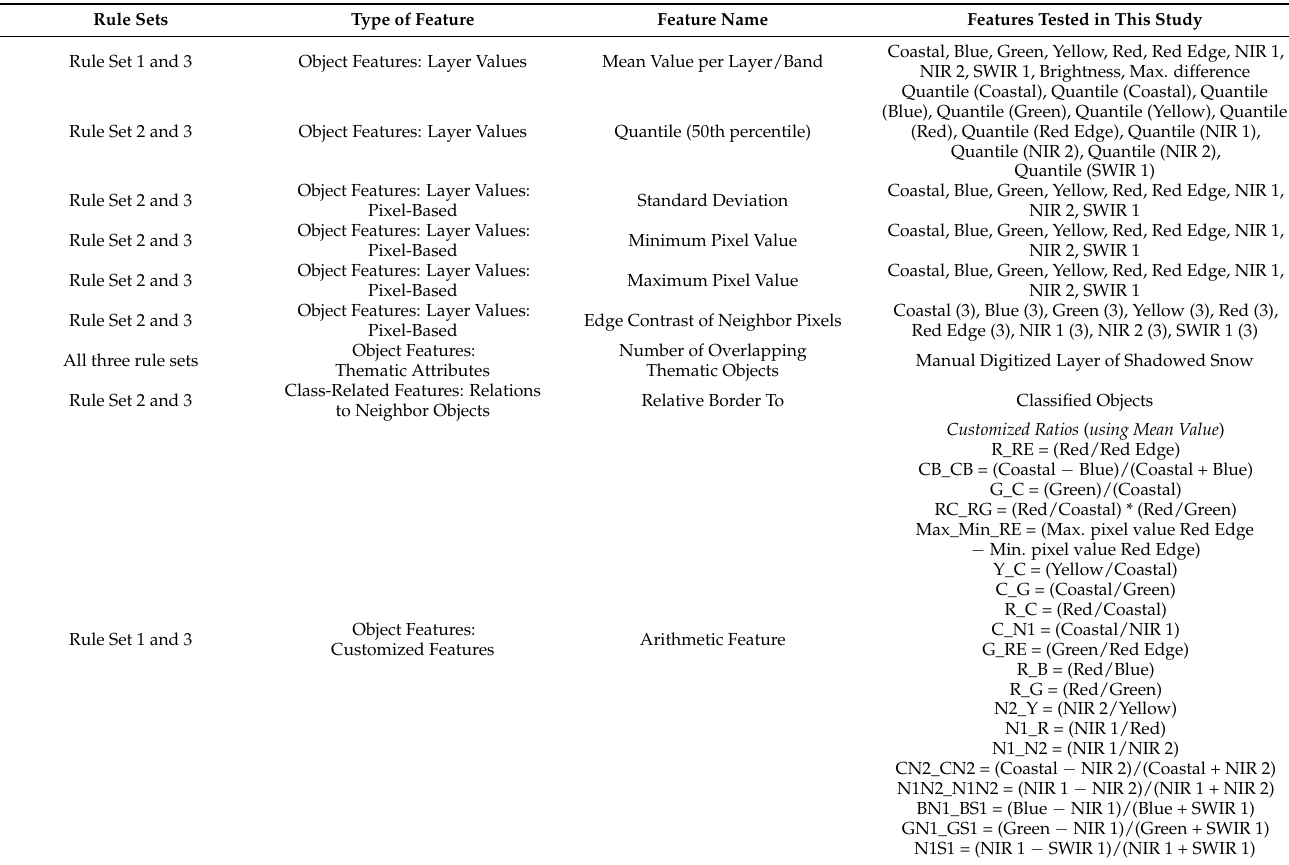
Table 5. Object features and the rule sets employing them for GEOBIA classification in the current